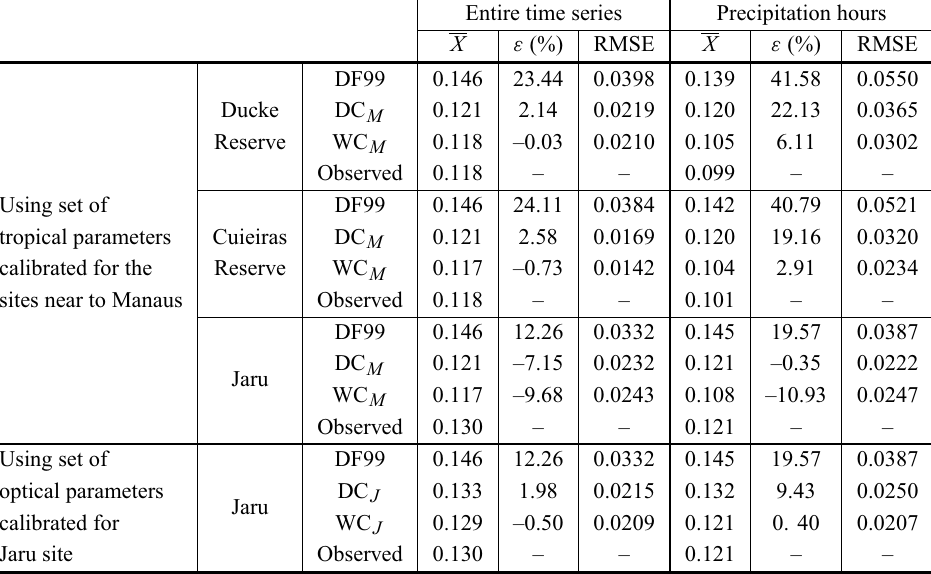
Statistics of observed and simulated surface albedos for the entire time series and for the precipitation hours at three sites in the Amazon rainforest (Cuieiras, Ducke and Jaru reserves), for the simulations based on the DF99 calibration, and for the new calibration using the dry-canopy (DC) and wet-canopy (WC) versions of the model. X is the average albedo, ε is the mean relative error, and RMSE is the root mean square